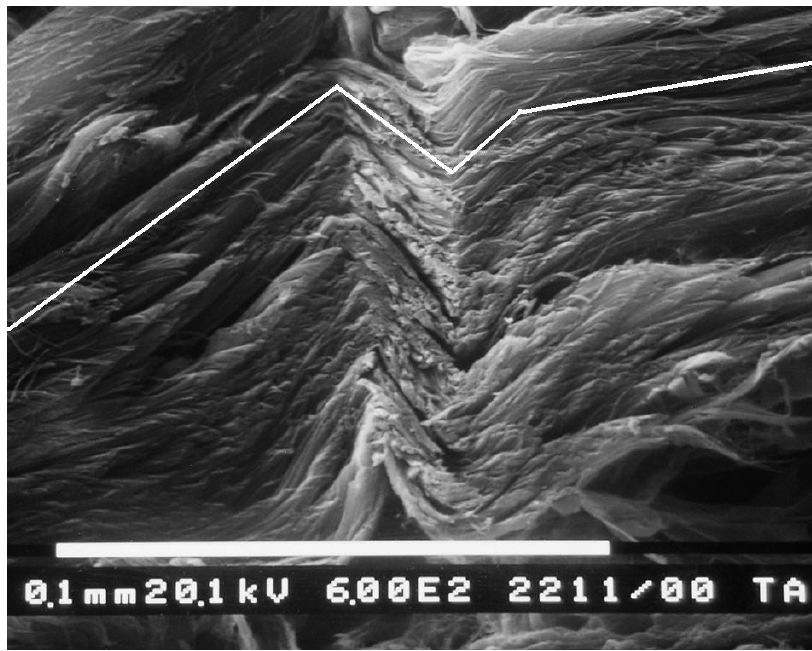
FIGURE 1. Rat Achilles tendon incubated in ChABC observed at SEM. Densely packed collagen fibers running almost straight and parallel appear interrupted by zig-zag undulations or crimps (indicated by the white line). Bar = 100 µm.